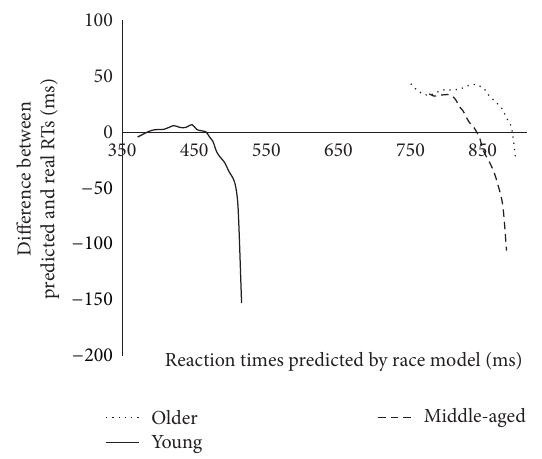
Figure 5: Differences between RTs predicted by the race model (solid horizontal line) and the observed RTs for young, middle-aged, and older